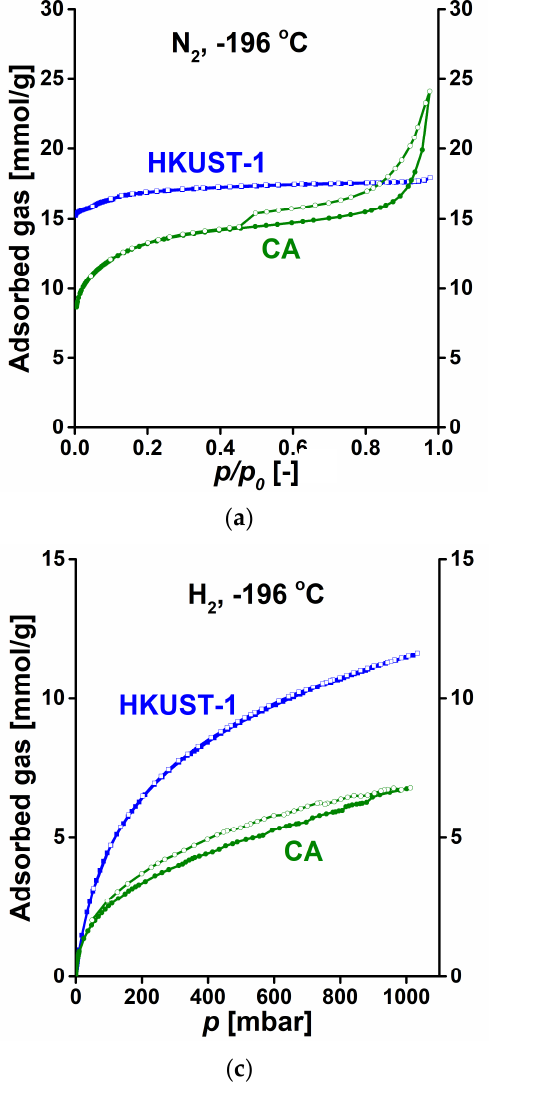
Figure 6. Comparison of adsorption isotherms of CA and HKUST-1 measured with ( a ) nitrogen, ( b ) carbon dioxide; ( c ) hydrogen; ( d ) methane.